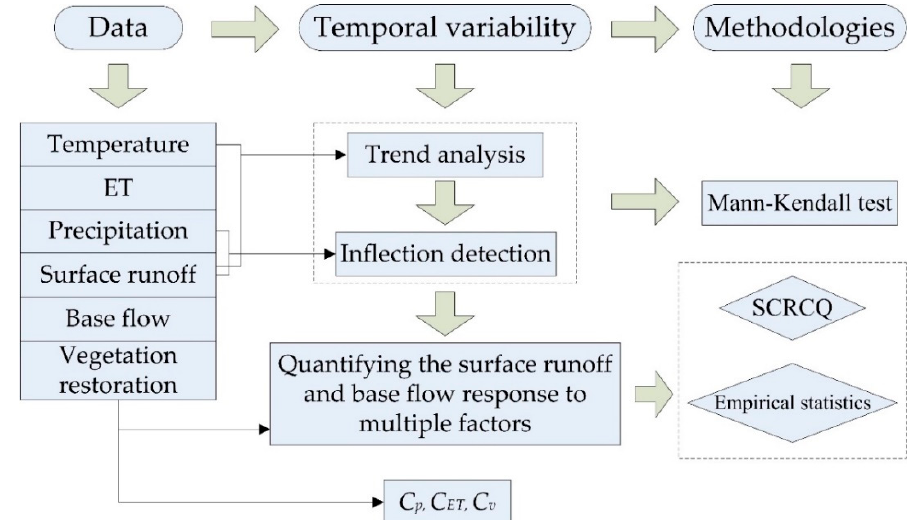
Figure 2. Graphical structure of this paper.